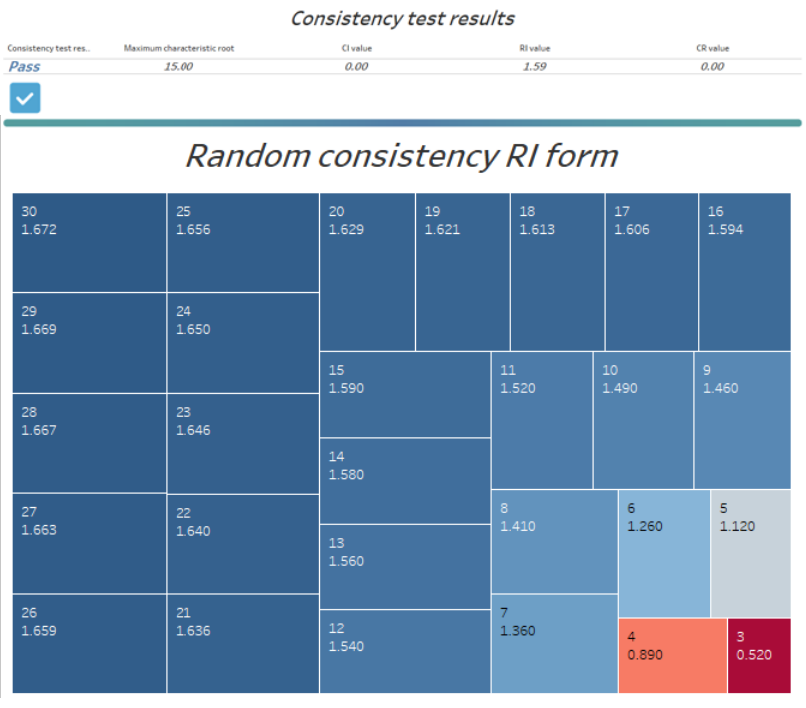
Figure 9. AHP consistency test analysis chart.